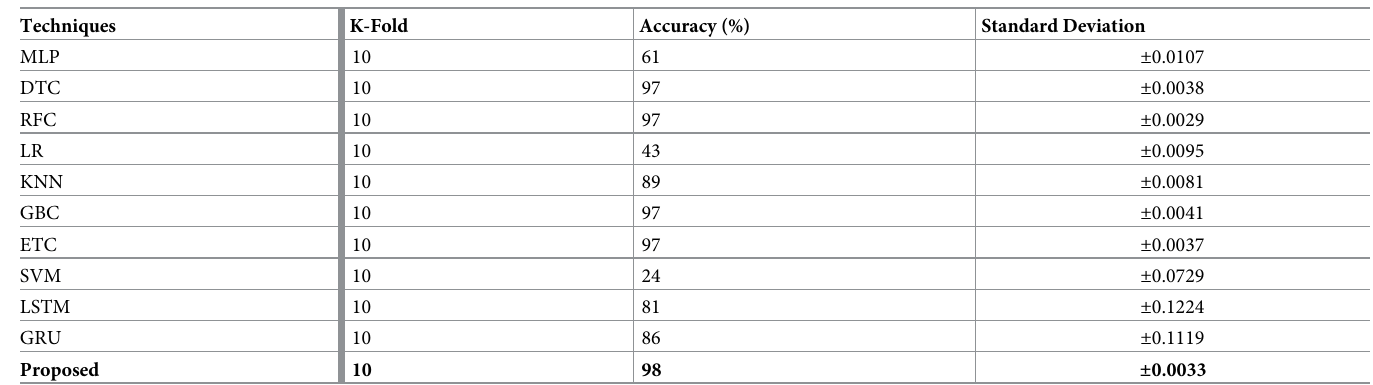
Table 6. K-fold cross-validation results of employed models.